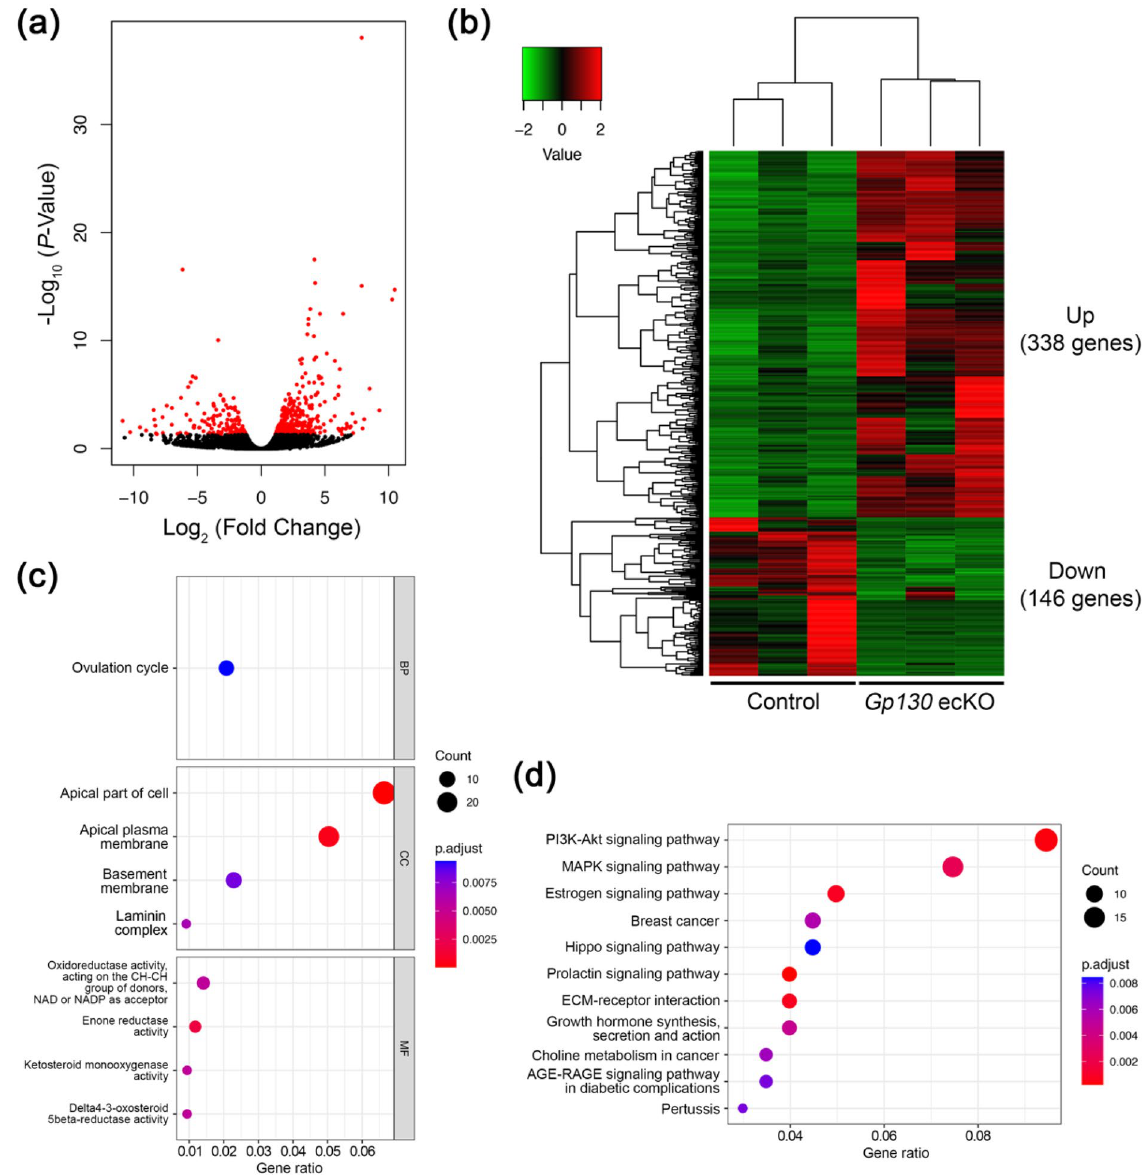
two-fold increase or decrease in Gp130 ecKO compared to the control (marked in red, FDR < 0.05). ( b ) Heatmap of differentially expressed genes. 338 genes are upregulated and 146 genes are down regulated in Gp130 ecKO. Heatmap was generated by the gplots v3.1.3 package in R v4.2.1 (URL https:// www.R- proje ct. org/). ( c ) Systematic characteristics of differentially expressed genes in Gp130 ecKO uteri compared to the control by